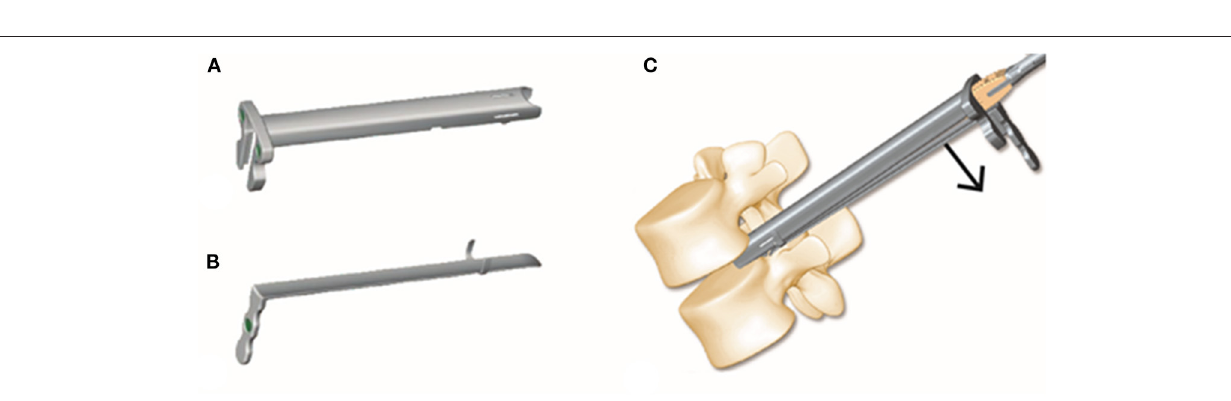
new Endo-TLIF system, conventional open reamers and curettes can be used for endplate preparation, and a rigid PEEK cage (from 12 to 14 mm) can be inserted into the disc. Compared with expandable cages, the placement of conventional PEEK cages can reduce complications such as cage migration and